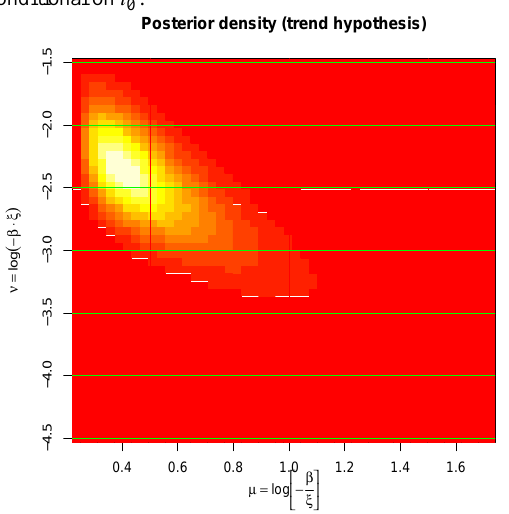
Fig. 7. Marginal posterior density for the slope in ν (spread). Pa- rameter ν is